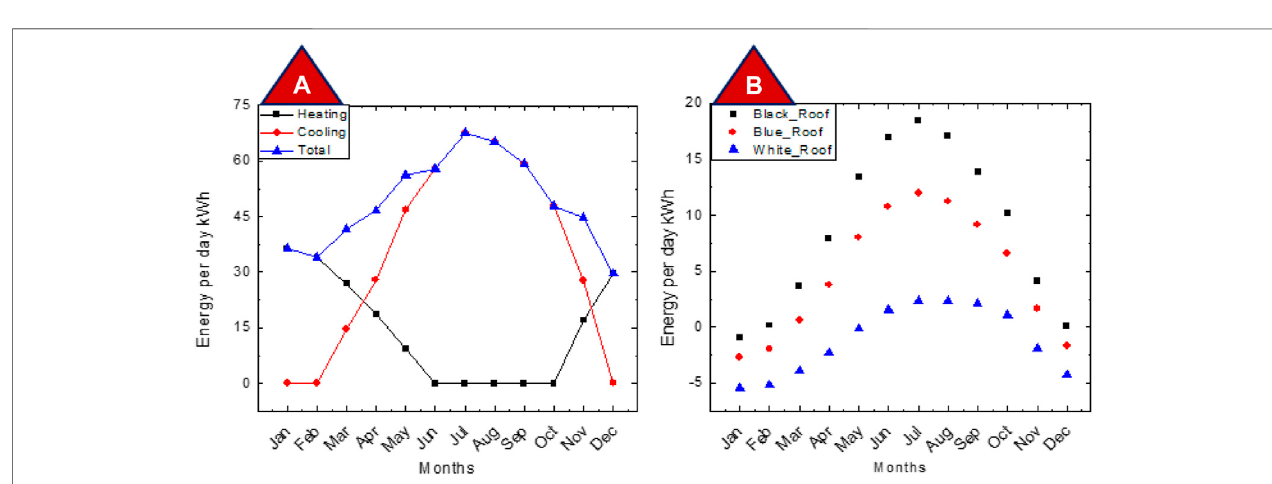
FIGURE 6 | Energy consumption for heating and cooling (A) and energy gain from the buildings ’ roof with different colors (B) .